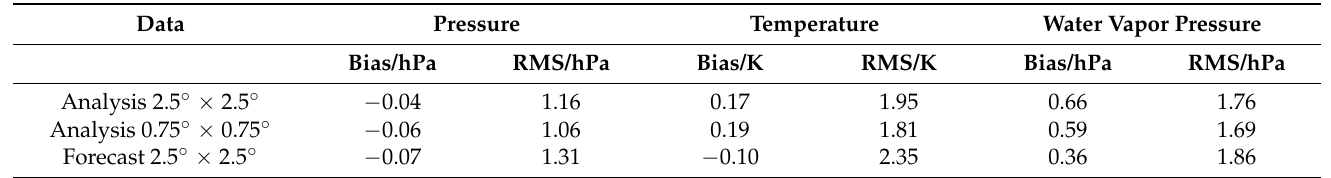
Table 2. Global statistics of accuracies of P , T , and e retrieved from ERA surface data with respect to radiosonde observations at the surface over 530 global IGRA stations in